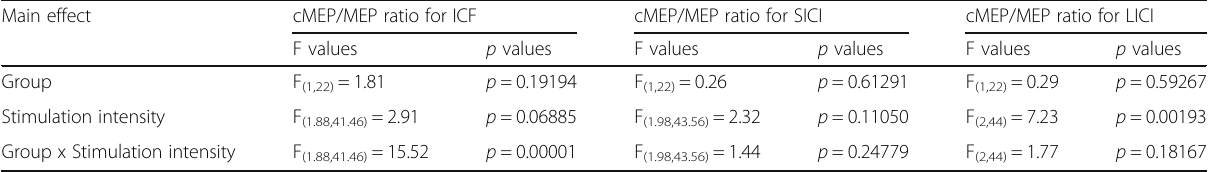
Table 2 ANOVA results for intracortical facilitation (ICF), short intracortical inhibition (SICI) and long intracortical inhibition (LICI) data in migraine patients and